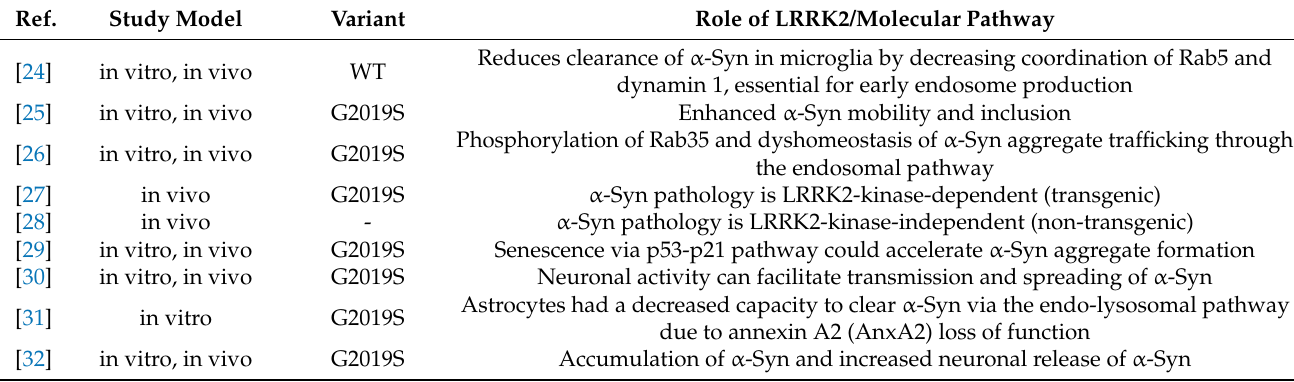
Table 2. Studies explore the relationship between LRRK2 and alpha-synuclein neurotoxicity.